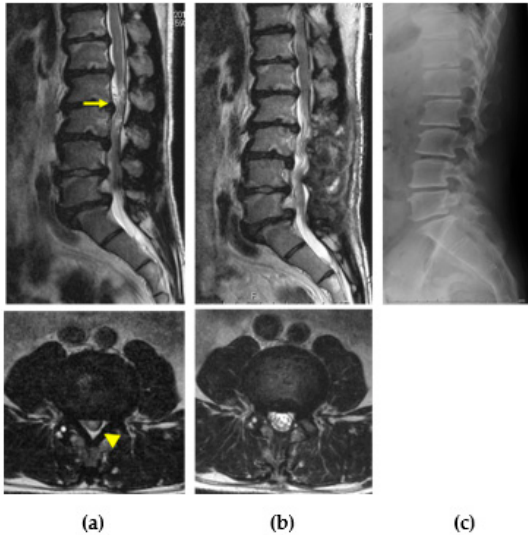
Figure 9. Lumbar canal stenosis in MPS II. Preoperative magnetic resonance images of a 37-year-old man with MPS II showing lumbar canal stenosis with redundant nerves (arrow), multiple disc degeneration and bulged discs, and hypertrophied ligamentum flavum (arrowhead) ( a ). Intermittent claudication disappeared after posterior decompression surgery. The spinal canal was enlarged, and nerve root redundancy also disappeared in postoperative magnetic resonance images ( b ). Vertebral deformity was not evident compared with MPS IV; however, isthmic spondylolysis and degenerative changes were observed in the plain radiograph ( c